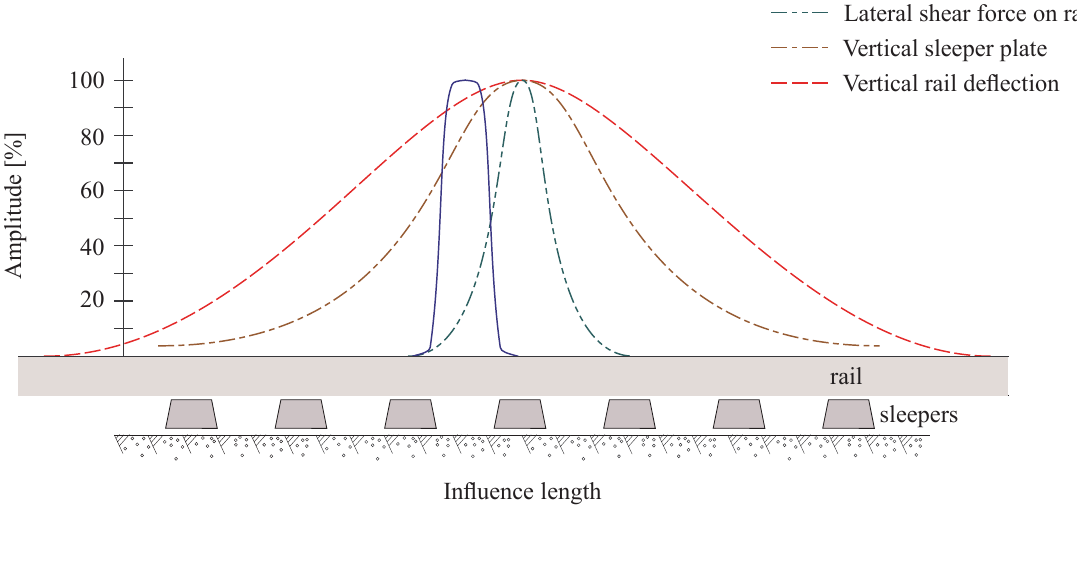
Figure 10. Qualitative influence of load measurement on track (adapted from